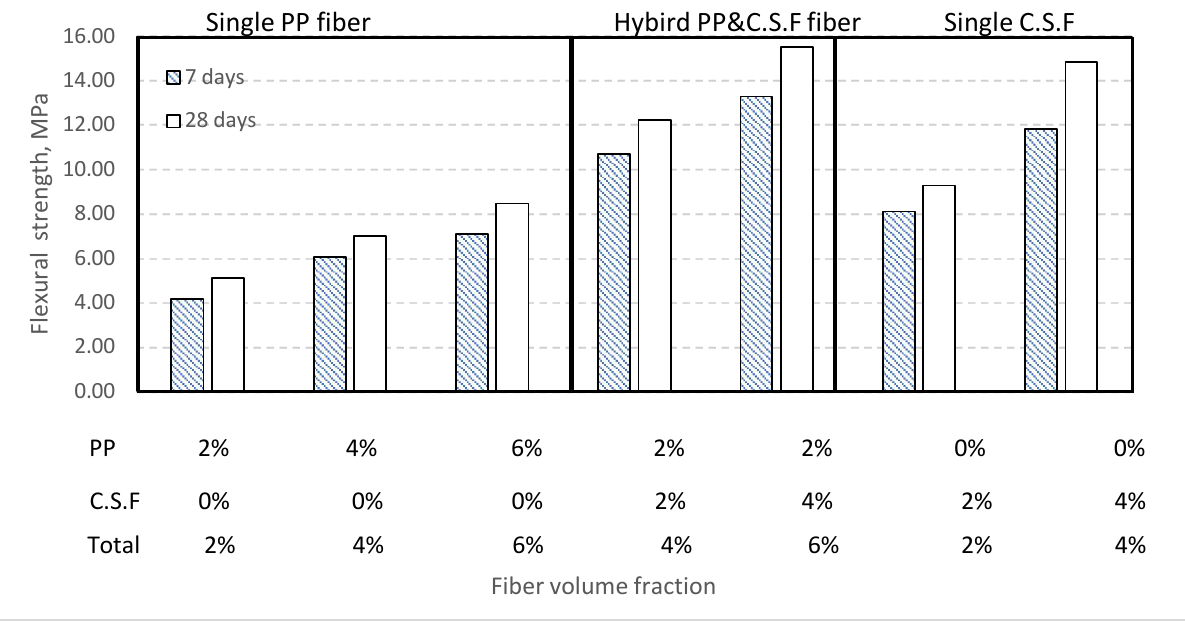
Figure 18. Effect of lightweight with heavyweight fiber hybridization on 7 and 28-day concrete flex- ural strength.